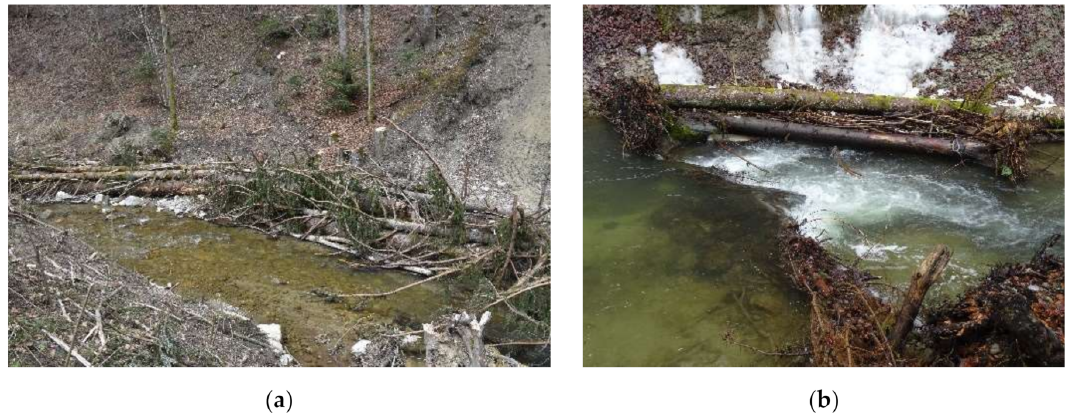
Figure 3. ( a , b ) Example of initially placed branches under LW. Instream restoration Witibach stream; Photos: V. Neuhaus.